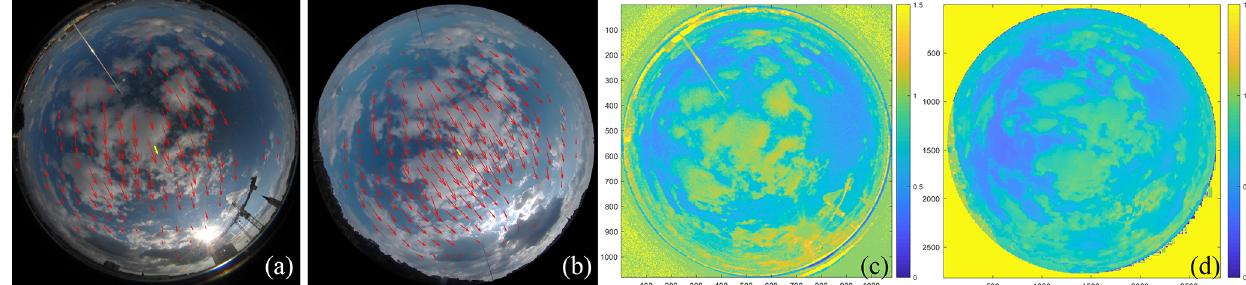
Figure 1. Cloud motion estimation (a, b) and cloud detection images (c, d) for the EKO (a, c) and the Vivotek (b, d) .